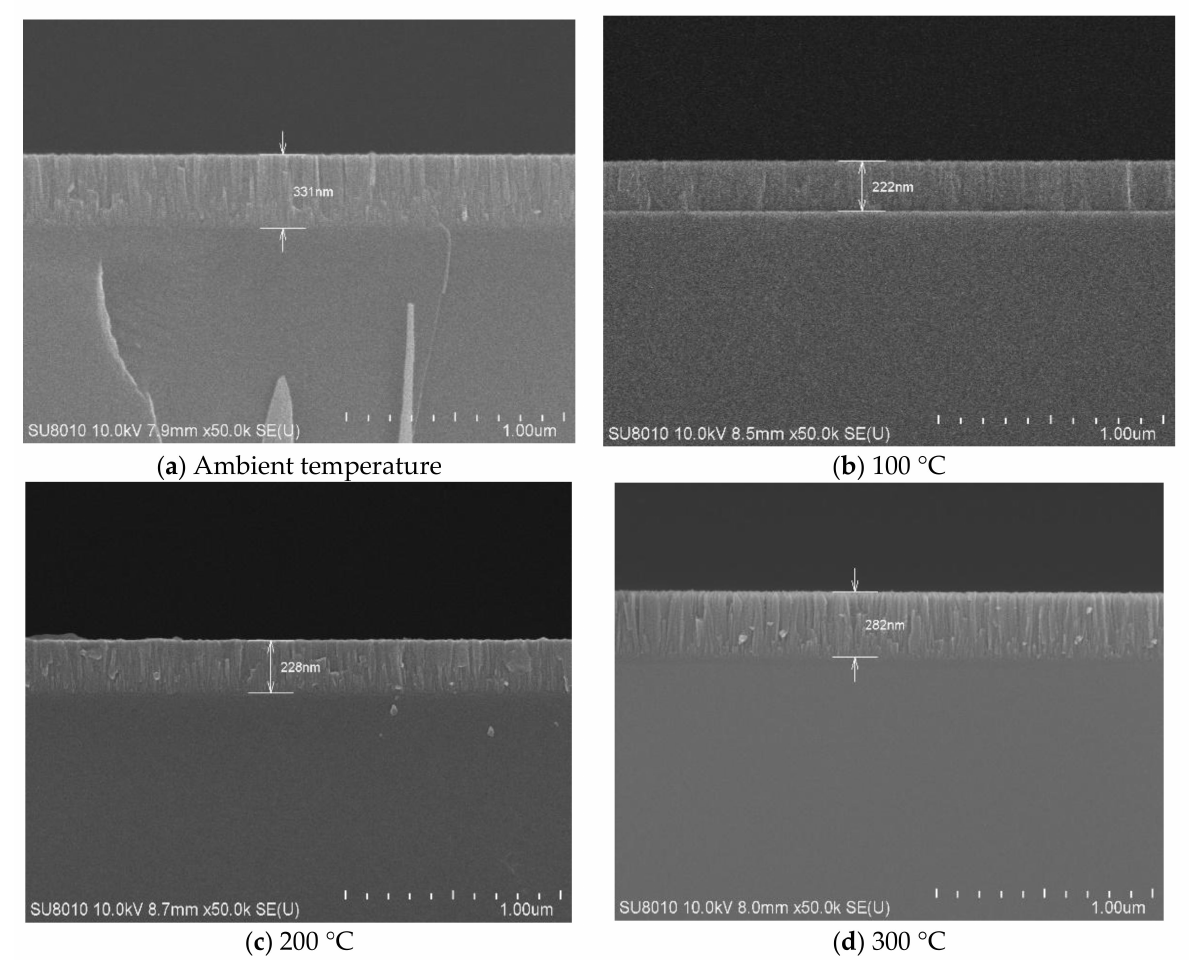
Figure 1. SEM cross-sectional image of the TiN thin film deposited with a substrate temperature variation: the thicknesses of the thin films deposited at ambient temperature, 100, 200, and 300 ◦ C are ( a ) 311 nm, ( b ) 222 nm, ( c ) 228 nm, and ( d ) 282 nm,